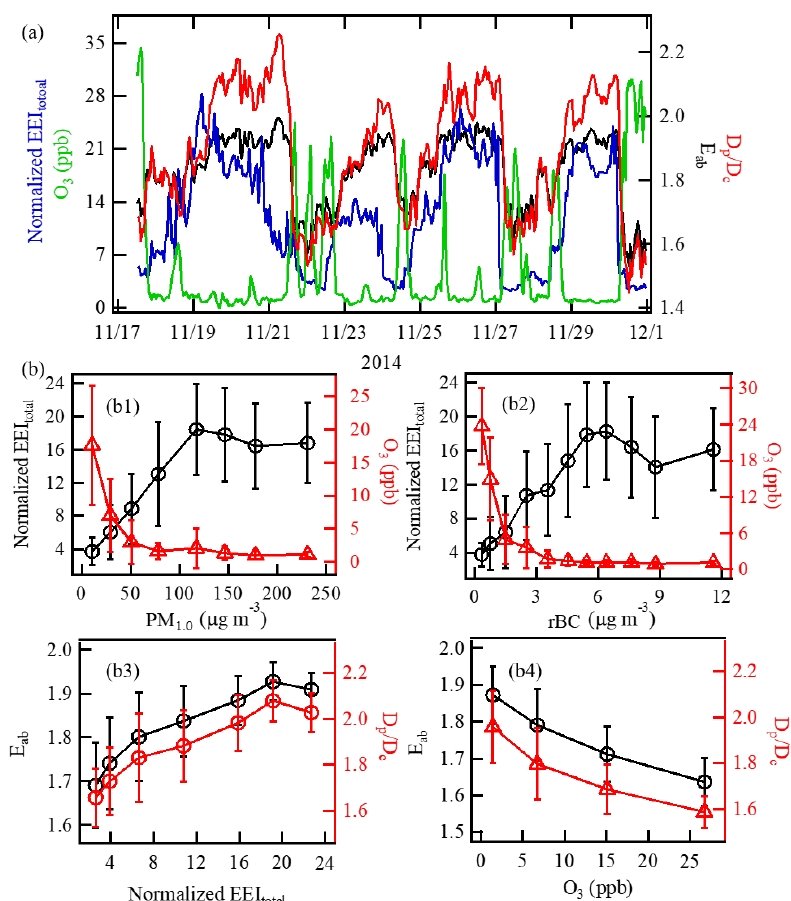
Figure 6. (a) Time series of the normalized EEI total , D p /D c ratios and E ab of BC-containing particles and the O 3 concentration during the campaign period. (b) Variations in the D p /D c and E ab of BC-containing particles with the normalized EEI total and O 3 concentration. Normalized EEI total (EEI total , normalized ) was calculated by scaling by a factor of 10 − 3 , namely EEI total , normalized = EEI total